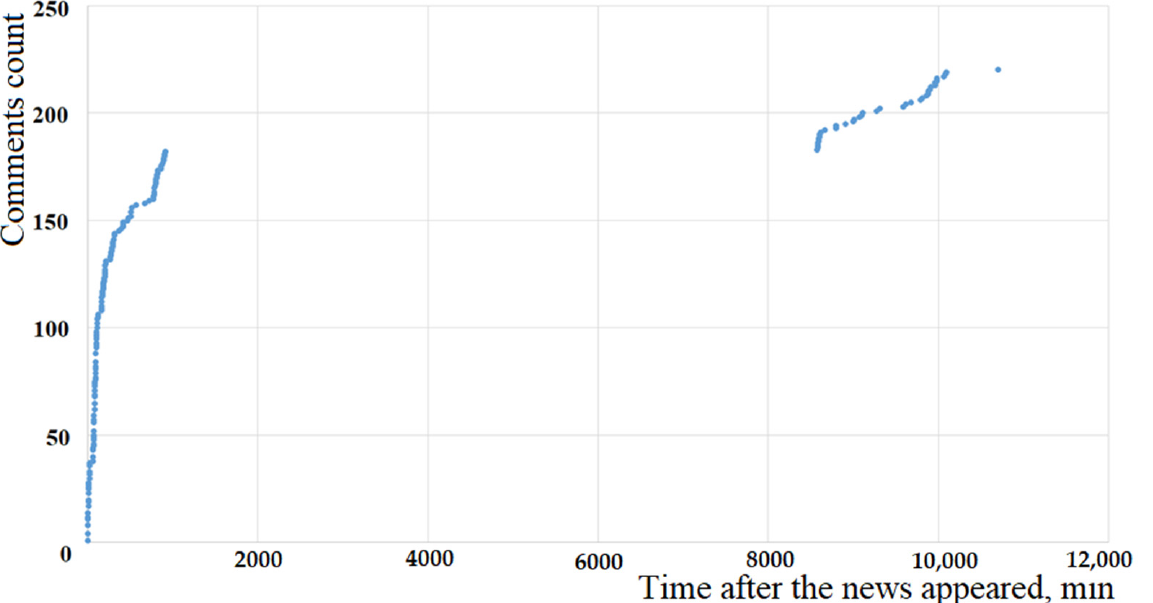
Figure 7. The observed dynamics of change over time, the number of comments on a news item of public interest that appeared on the portal https://echo.msk.ru/news/2740844-echo.html on